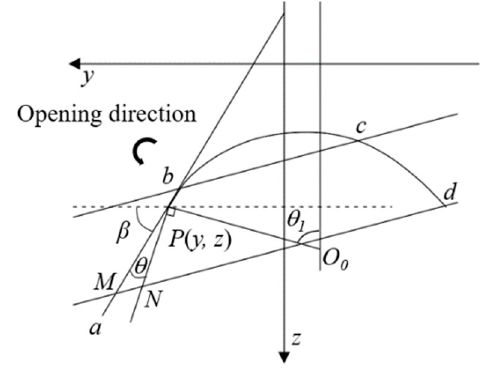
Figure 8. Contact angle of seal pair during closing and opening.